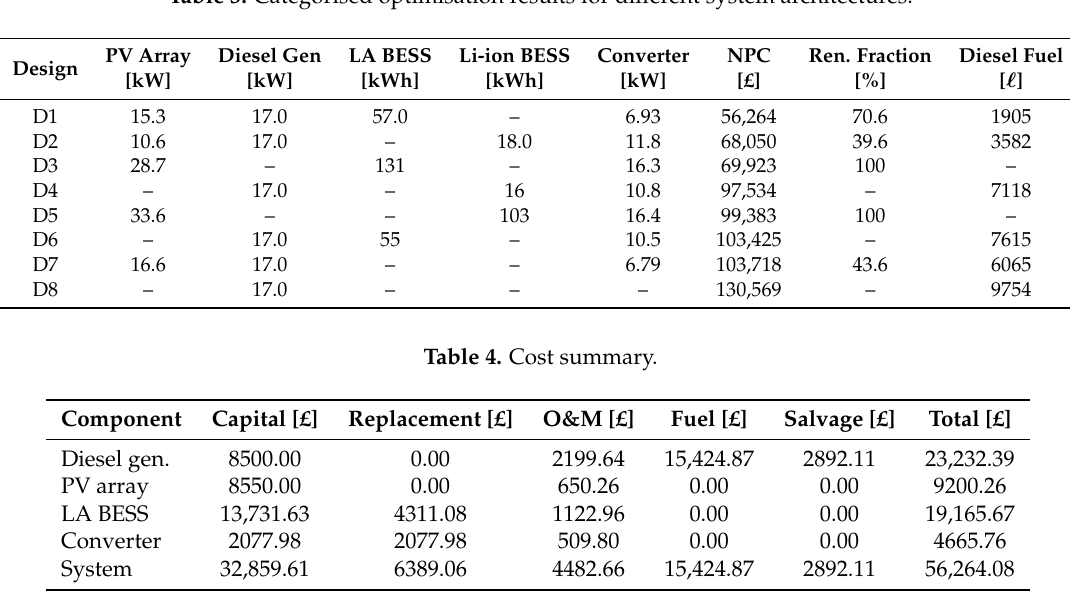
Table 3. Categorised optimisation results for different system architectures.